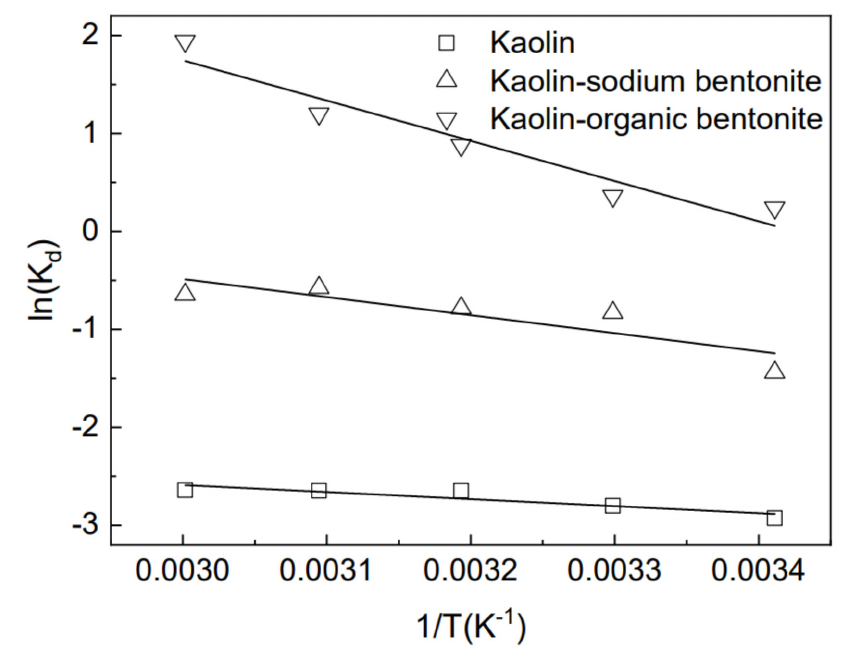
Figure 11. Plots of ln K d versus 1/T for the three adsorbents. Table 4. Thermodynamic parameters for the adsorption of rhodamine B by the three adsorbents. Temperature/(°C) 20 30 40